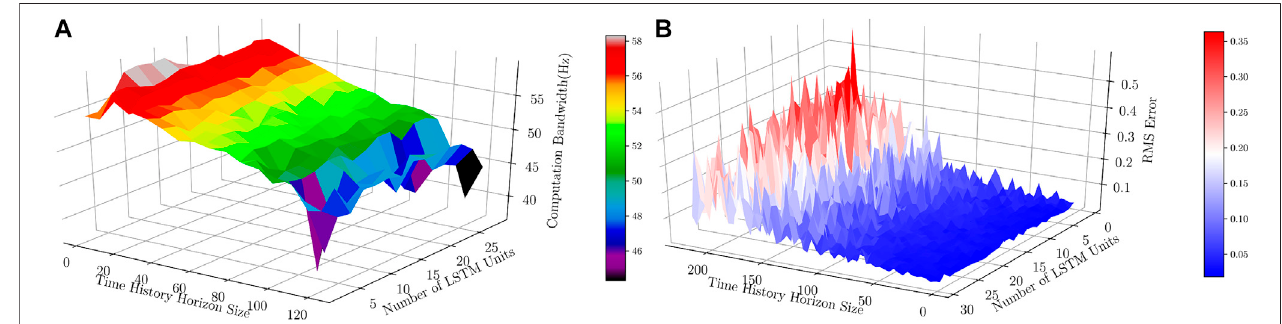
FIGURE14|(A) :Computationbandwidth(Hz)obtainedwithrespect todifferentnumber ofLSTMunits andsizeoftimehistoryhorizon(fornumberofepochs (cid:2) 25 and batch size (cid:2) 1). (B) : RMS Error (mm) of the prediction on Data-set IV using trained models with different number of LSTM units and size of time history horizons (for number of epochs (cid:2) 25 and batch size (cid:2)